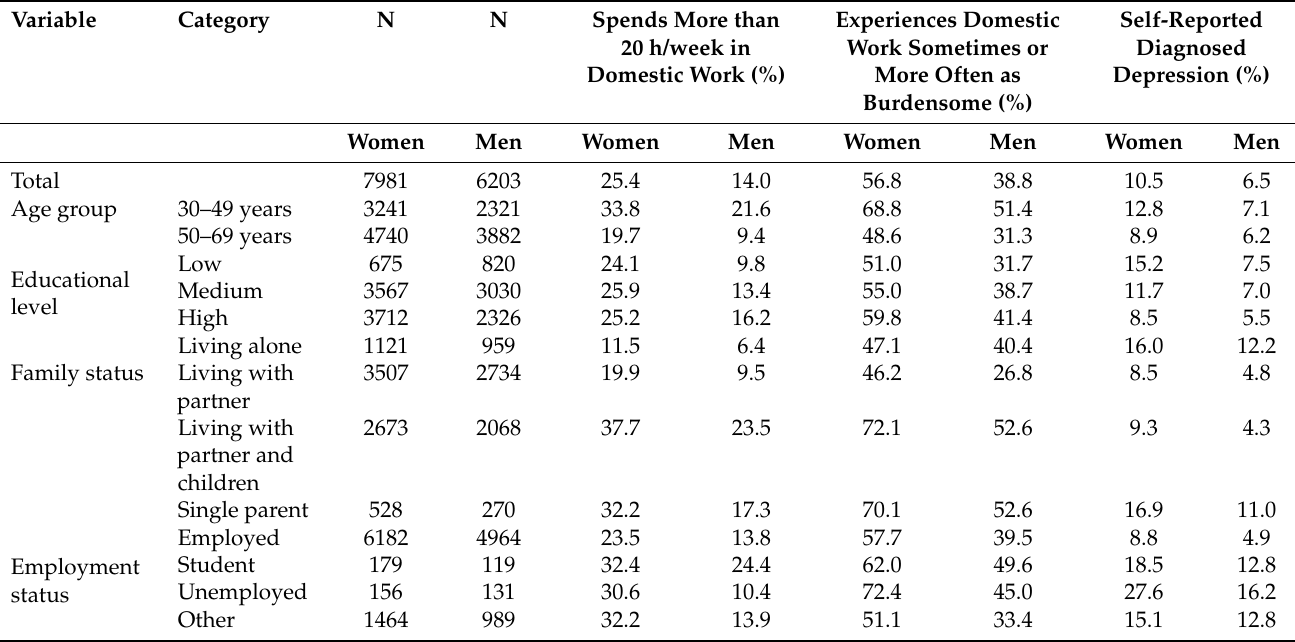
Table 1. Number of respondents, proportion spending more than 20 h on domestic work per week, burdensome domestic work, and prevalence of self-reported diagnosed depression in different socio-demographic